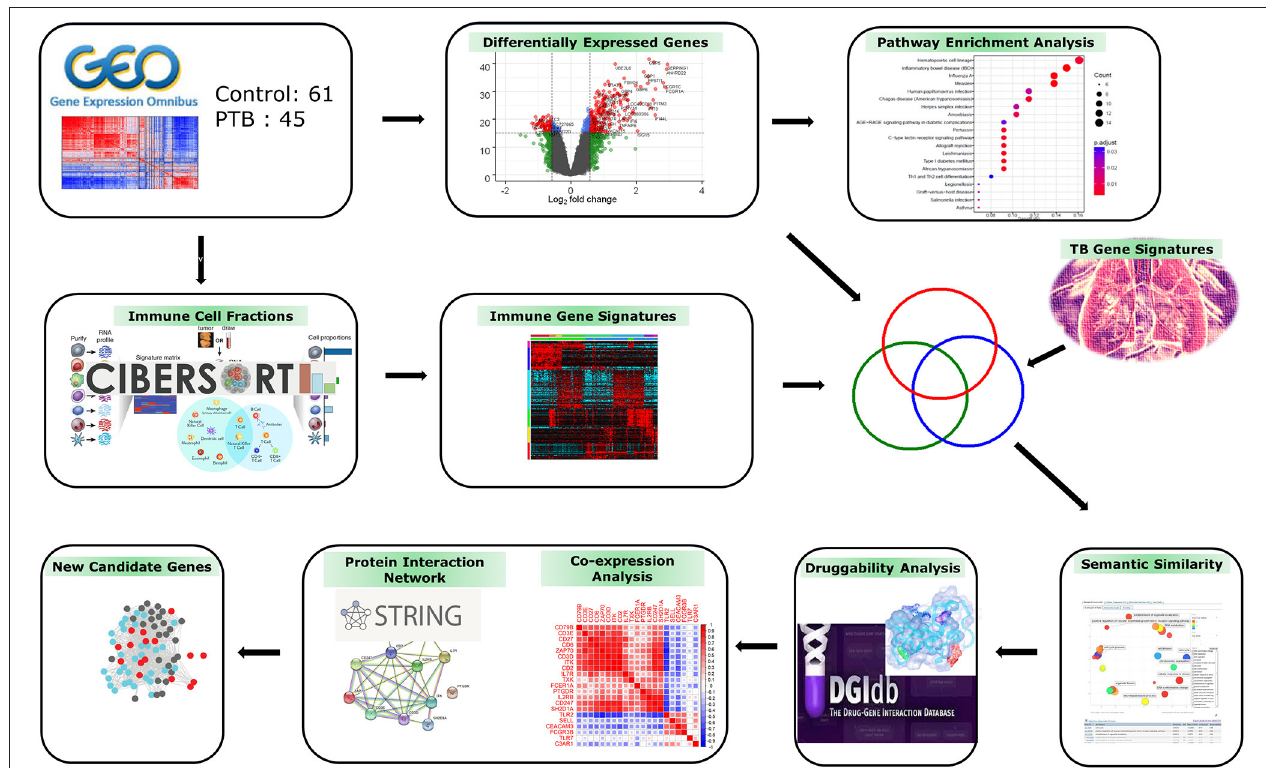
FIGURE 1 | Study workflow. The gene expression profiles of patients with tuberculosis (TB) and controls were used to deconvolute immune cell fractions. Differentially expressed genes (DEGs) were mapped to functional pathways and then correlated with immune cell and TB meta-analysis gene signatures. The overlapping genes showing semantic similarity were explored by druggability and protein interaction analysis to identify novel candidate therapeutic targets/biomarkers for combating TB